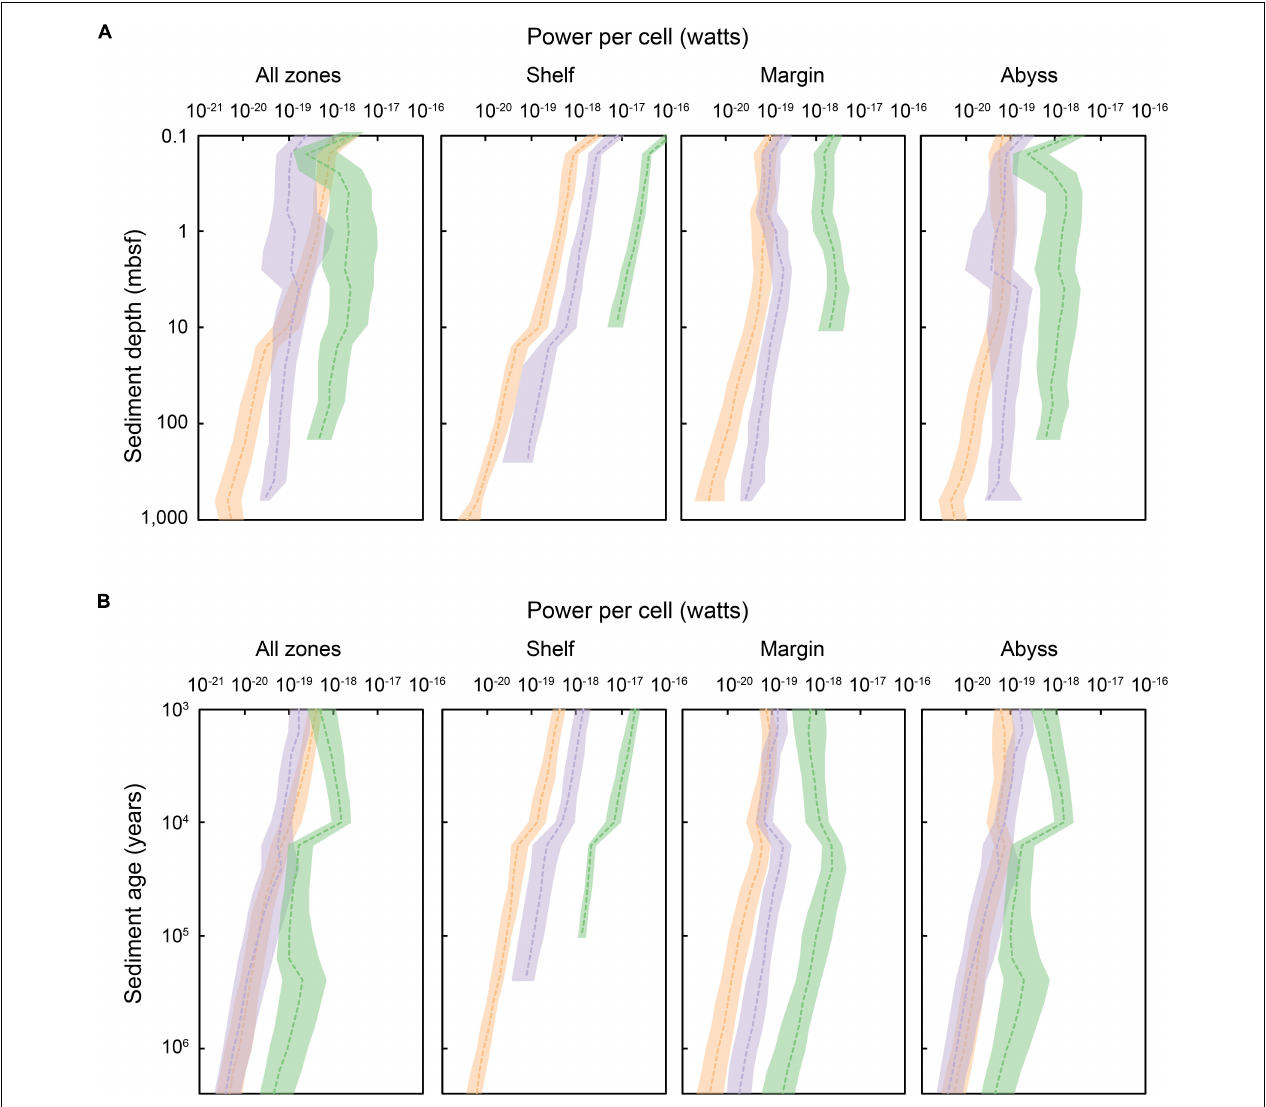
FIGURE 6 | The energy flux (i.e., power) per cell in global marine sediments, according to equal (A) sediment depth (shown for sediments at 0.1 to ∼ 10,000 mbsf) and (B) sediment age (1,000 years to 2.59 million years). Shading indicates the redox-state of the sediment in which cells are situated: green shading represents oxic zones, lilac denotes sulfate-reducing zones, and orange signifies methanogenic zones. The dashed colored lines represent the median power per cell within a specific horizon, depositional environment, and redox setting. Power per cell is spatially variable for a given sediment depth or age layer. The shaded area indicates the upper and lower quartiles of power per cell for a specific depth or age